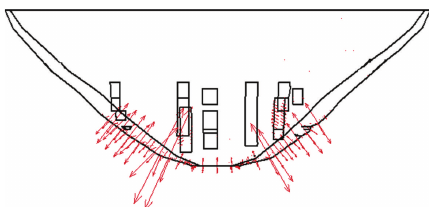
Figure 15: Distribution of dam body unbalanced force under over- load 2.0𝑃 0 in scheme 3.